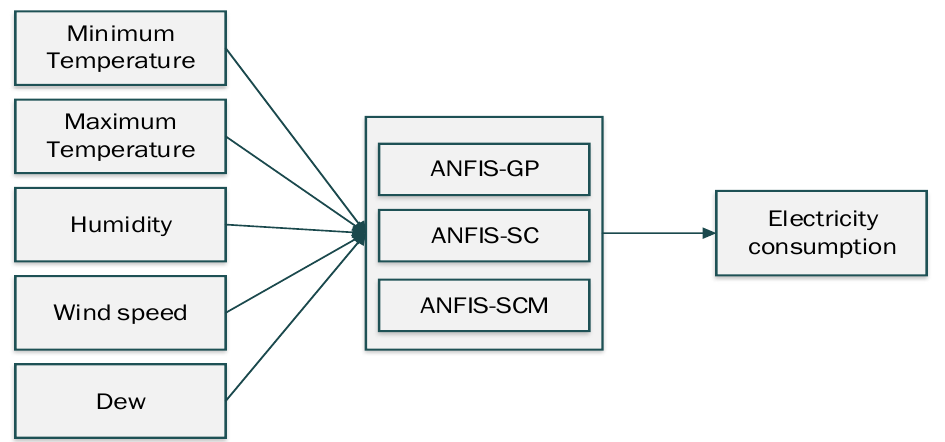
Figure 3. Map showing the geographical location of the study area.